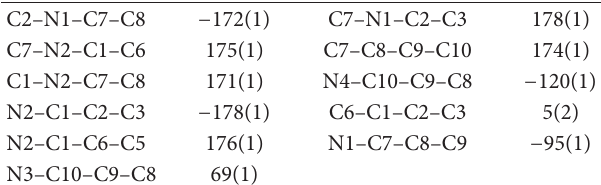
T 3: Selected torsion angles (